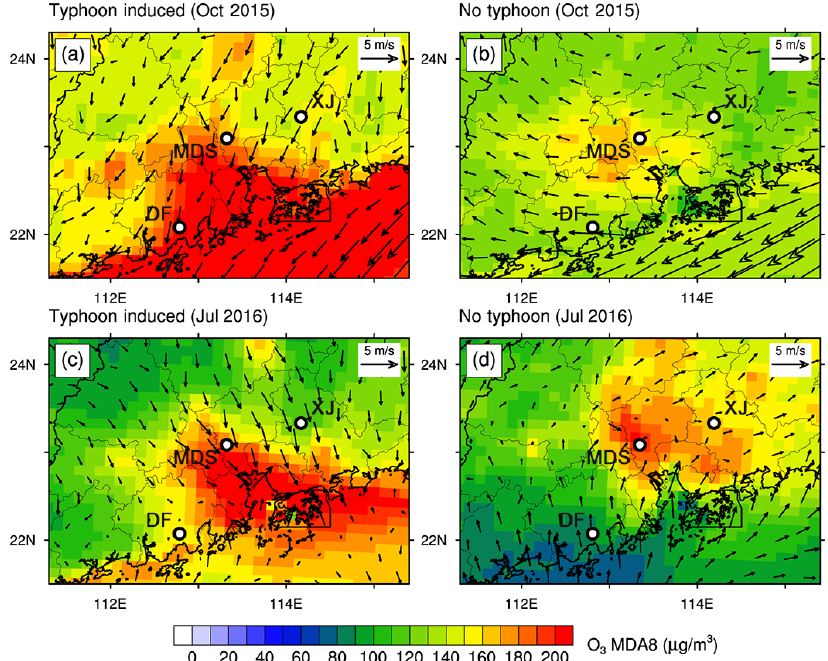
Figure 8. Modelling mean O 3 MDA8 concentrations (micrograms per cubic metre; hereafter µgm − 3 ) and wind vectors (at 14:00LT) on the representative O 3 pollution days. (a) The typhoon-induced days in October 2015 (14–16 and 21 October 2015). (b) The no-typhoon days in October 2015 (28 October and 3–5 November 2015). (c) The typhoon-induced days in July 2016 (7–8 and 30–31 July 2016). (d) The no-typhoon days in July 2016 (22–26 and 29 July 2016). Three representative sites in the PRD are shown as black circles in the plots: XJ – Xijiao; MDS – Modiesha; DF – Duanfen.